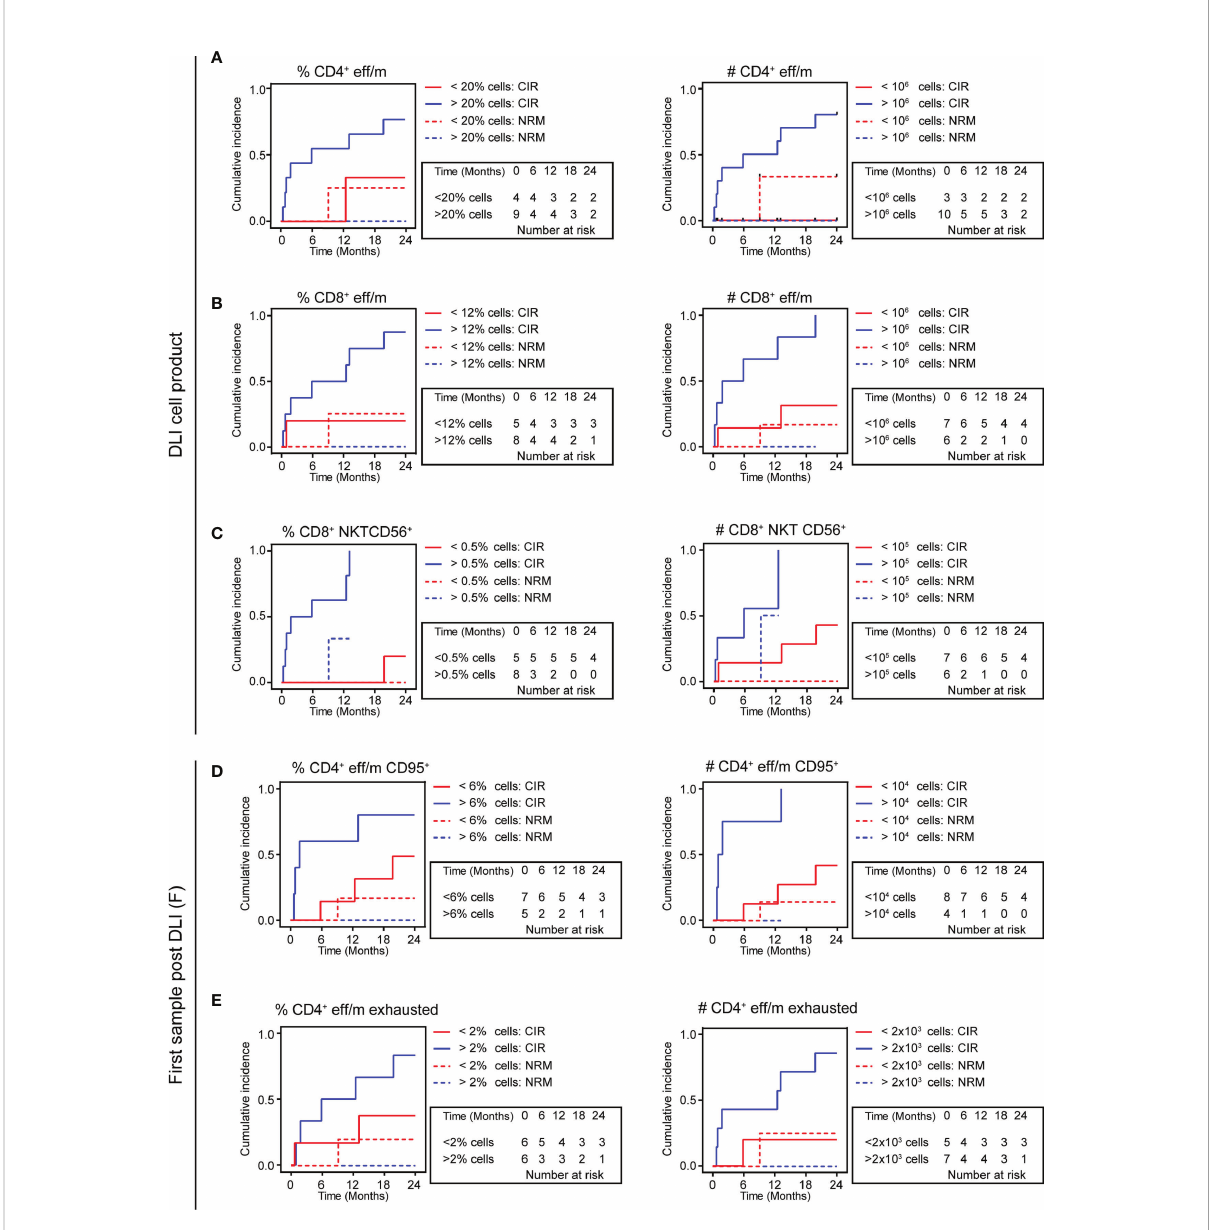
FIGURE 4 Relapse incidence is predicted by high vs. low eff/m T cell clusters. (A – E) Cumulative incidence curves (24 months follow-up) are displayed with relapse incidence (CIR, solid lines) and non-relapse mortality (NRM, dotted lines) as competing events for DLI cell products (A – C) or patient samples early after DLI (D, E) , discriminating between low (red) and high (blue) frequencies or absolute counts. (A) Shows in the left panel results for DLI cell products ’ frequencies of CD4 + eff/m (>20% cells, n=9 vs. <20% cells, n=4, CIR, p=0.098; NRM, p=0.140), and in the right panel DLI cell products ’ absolute counts of CD4 + eff/m (>10 6 cells/ml, n=10 vs. <10 6 cells/ml, n=3, CIR, p=0.039; NRM, p=0.071). (B) Shows in the left panel results for DLI cell products ’ frequencies of CD8 + eff/m (>12% cells, n=6 vs. <12% cells, n=7, CIR, p=0.045; NRM, p=0.217), and in the right panel DLI cell products ’ absolute counts of CD8 + eff/m (>10 6 cells/ml, n=6 vs. <10 6 cells/ml, n=7, CIR, p=0.009; NRM, p=0.382). (C) Shows in the left panel results for DLI cell products ’ frequencies of CD8 + CD16 + CD56 + (>0.5% cells, n=8 vs. <0.5% cells, n=5, CIR, p=0.005; NRM, p=0.443), and in the right panel DLI cell products ’ absolute counts of CD8 + CD16 + CD56 + (>10 5 cells/ml, n=6 vs. <10 5 cells/ml, n=7, CIR, p=0.023; NRM, p=0.308). (D) Shows in the left panel results for patient samples ’ frequencies of CD4 + eff/m (>6% cells, n=5 vs. <6% cells, n=7, CIR, p=0.098; NRM, p=0.422), and in the right panel patient samples ’ absolute counts of CD4 + eff/m (>10.000 cells/ml, n=4 vs. <10.000 cells/ ml, n=8, CIR, p=0.004; NRM, p=0.536). (E) Shows in the left panel results for patient samples ’ frequencies of exhausted CD4 + eff/m (>2% cells, n=6 vs. <2% cells, n=6 CIR, p=0.124; NRM, p=0.332), and in the right panel patient samples ’ absolute counts of exhausted CD4 + eff/m (>2.000 cells/ml, n=7 vs. <2.000 cells/ml, n=5, CIR, p=0.046; NRM, p=0.248) and in the right panel. CIR and NRM were investigated by means of cumulative incidence curves employing Gray ’ s